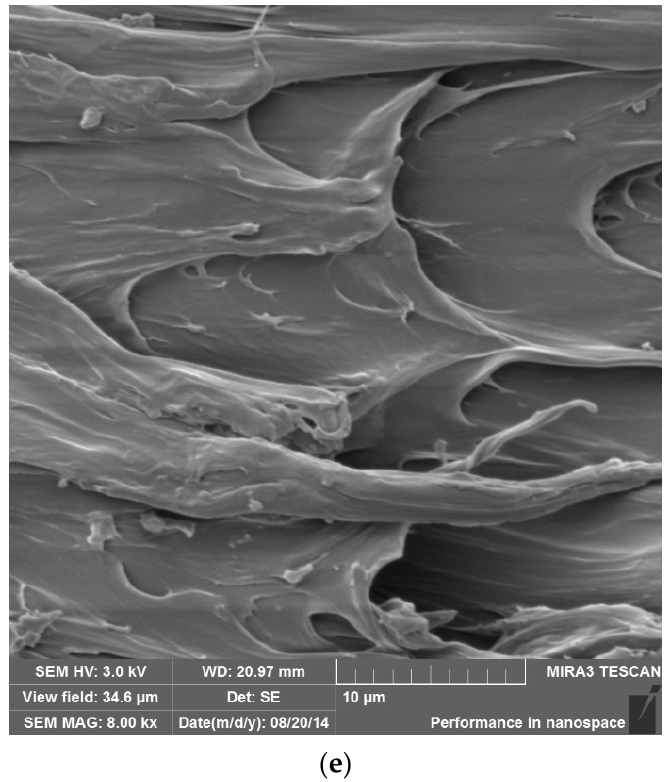
Figure 4. SEM–FEG of PVA after milling in an Attritor–type mill: ( a ) PVA milled for 0.5 h; ( b ) PVA milled for 2 h; ( c ) PVA milled for 4 h; ( d ) PVA milled for 16 h; ( e ) surface detailed image from PVA milled for 4 h.